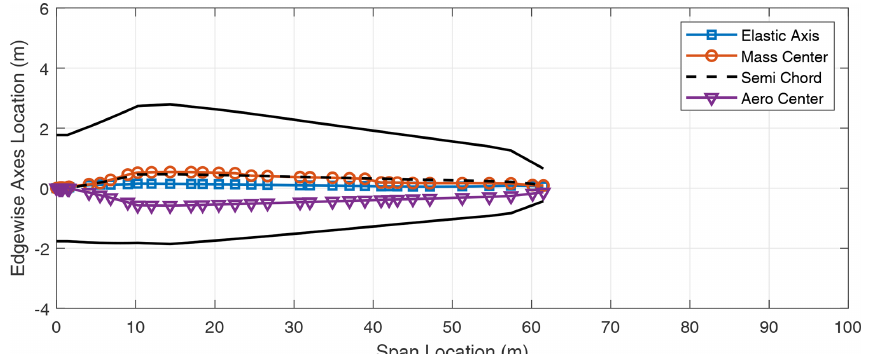
Figure A3. Planform for the NREL 5MW turbine